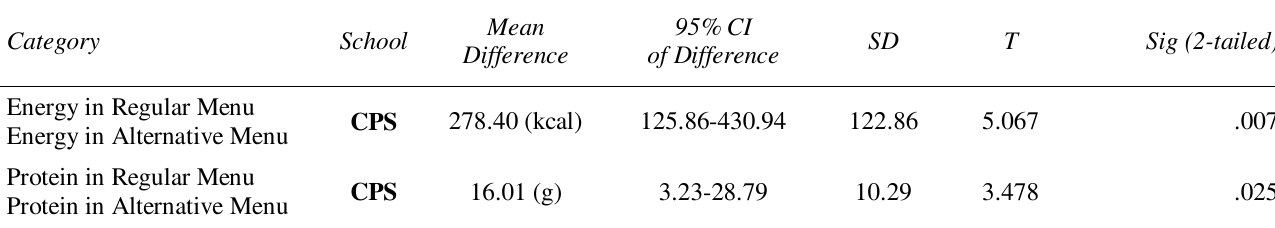
Table 7: Differences between nutrients in the regular menu and nutrients in the alternative menu of Canton Public Schools